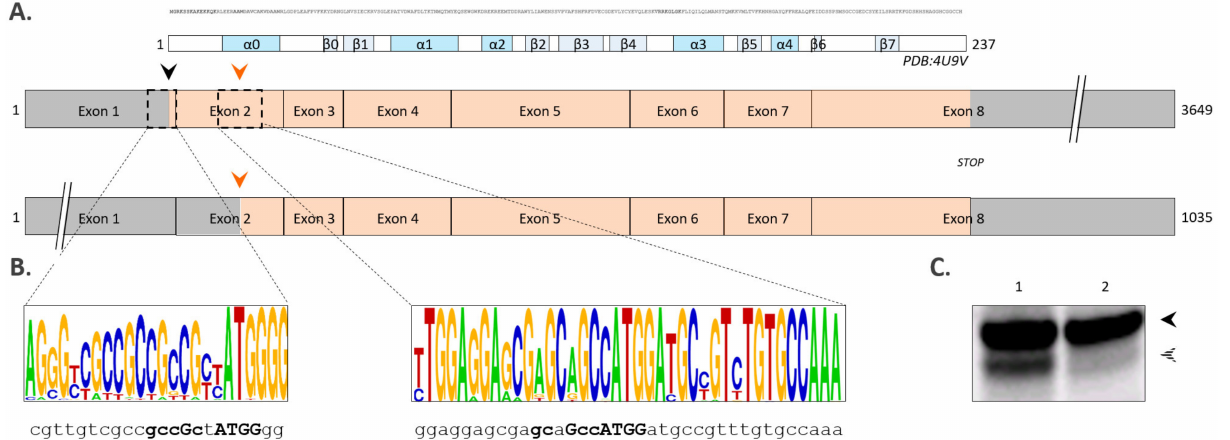
Figure 3. Alternative splicing or alternative translation can give rise to hNaa40 S expression. ( A ) Scheme depicting two alternatively spliced h NAA40 transcripts; being transcript ENST00000377793.9 (3649 bp, transcript expected to code for the main functional isoform with transcript support level 1 according to the APPRIS database (http://appris.bioinfo.cnio.es, accessed on 1 December 2020)) and transcript ENST00000542163.1 (1035 bp, transcript support level 2). Exons are indicated as boxes and corresponding non-coding and coding regions colored grey and orange, respectively. When considering the longest transcript, hNaa40 L and hNaa40 S translation initiates at the first (black arrow) and second in-frame AUG codon (orange arrow), respectively. Exon 1 encodes for the first 2 amino acids of hNaa40 L . The protein sequence of hNaa40 L (aa 1-237) with an indication of corresponding secondary structure elements of structure PDB:4U9V is provided above the transcripts. ( B ) Codon alignment of representative mammalian genomic sequences (alignment set hg38_58) in the vicinity of the canonical, database-annotated AUG TIS (dbTIS) (matching the human chr11:63939079-63939102 sequence indicated below) and the downstream AUG TIS (dTIS) (chr11:63945879-63945917 in human) of the NAA40 locus using WebLogo. The heights of the nucleotides are indicative for their degree of conservation at the indicated position [27]. ( C ) Autoradiograph showing translation initiation of in vitro transcribed h NAA40 at the AUG start codons encoding M1 (black arrowhead) and M22 (dashed arrowhead). For this, wild type (1) and a dTIS mutagenized (mutation of ATG encoding M22 to CTG (dTIS > CTG)) h NAA40 pOTB7 constructs were in vitro transcribed and translated, and radiolabeled proteins visualized by radiography following sodium dodecyl sulfate (SDS)-PAGE and